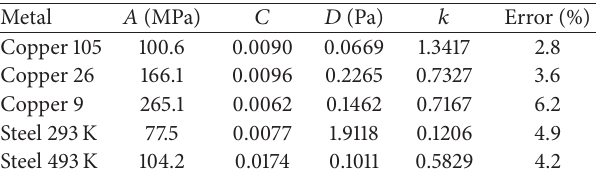
Table 5: Material constants and errors obtained by Couque equa- tion.